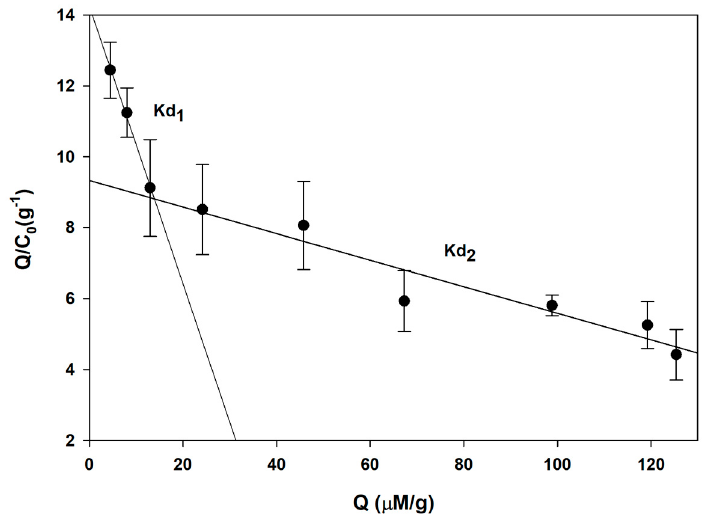
Figure 5. Scatchard analysis of MIPs.